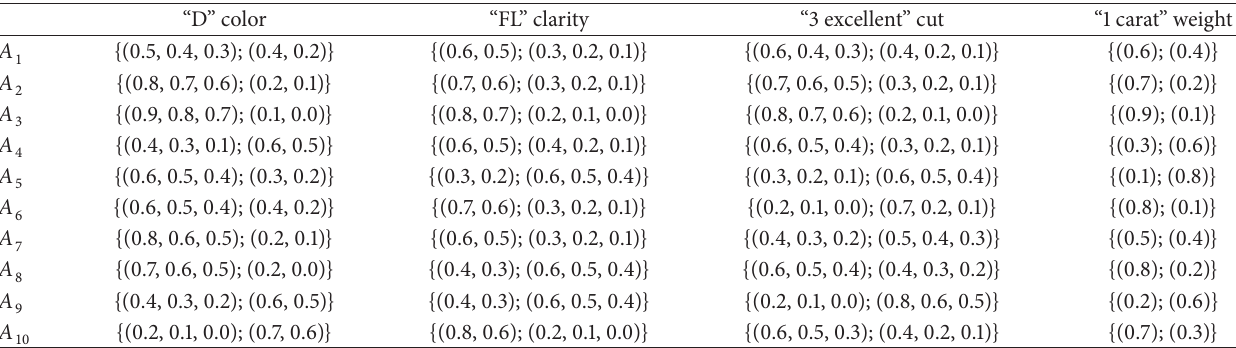
Table 6: Diamond data